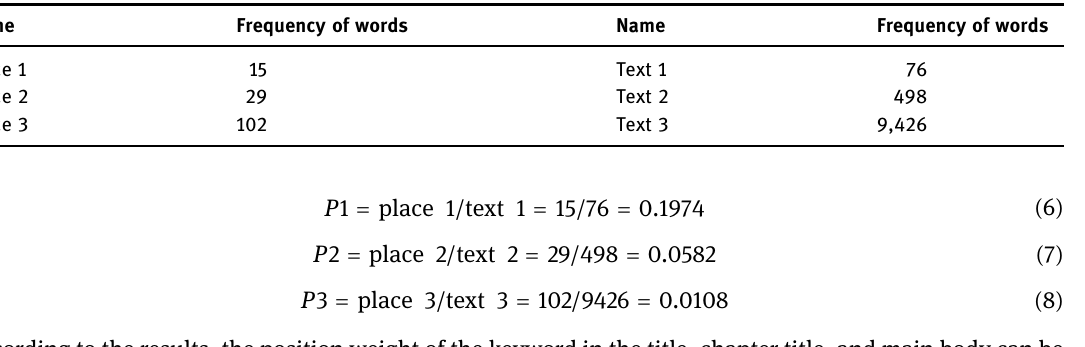
Table 1: Statistical results of text